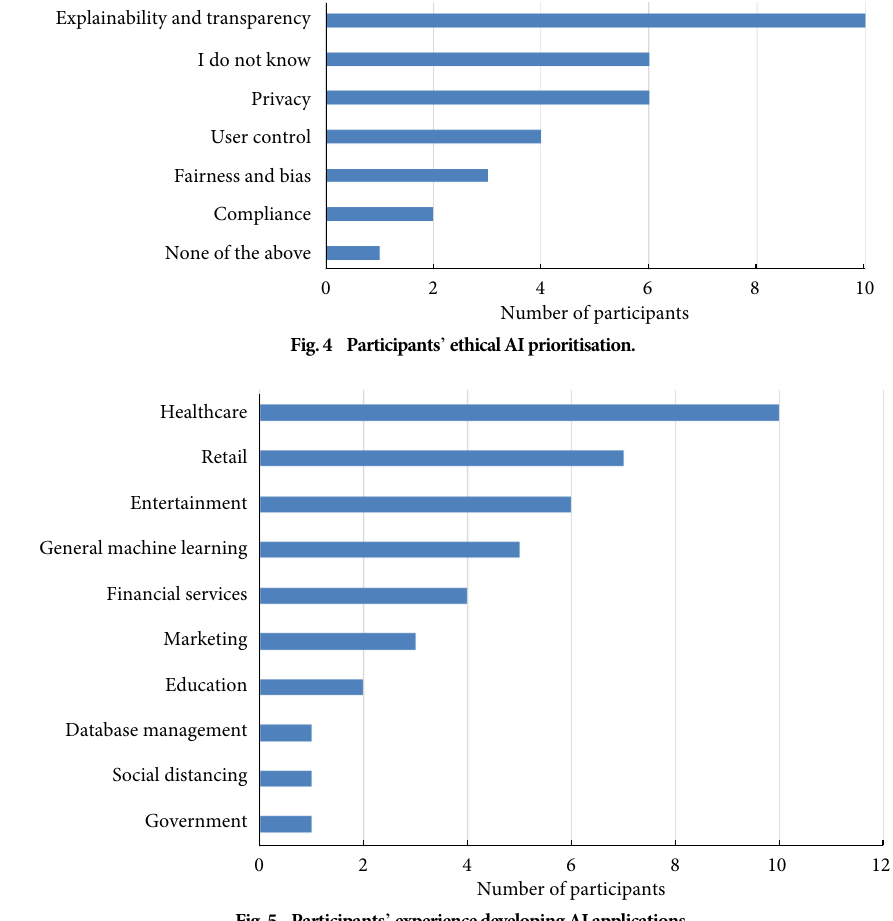
Fig. 5 Participants ’ experience developing AI applications.